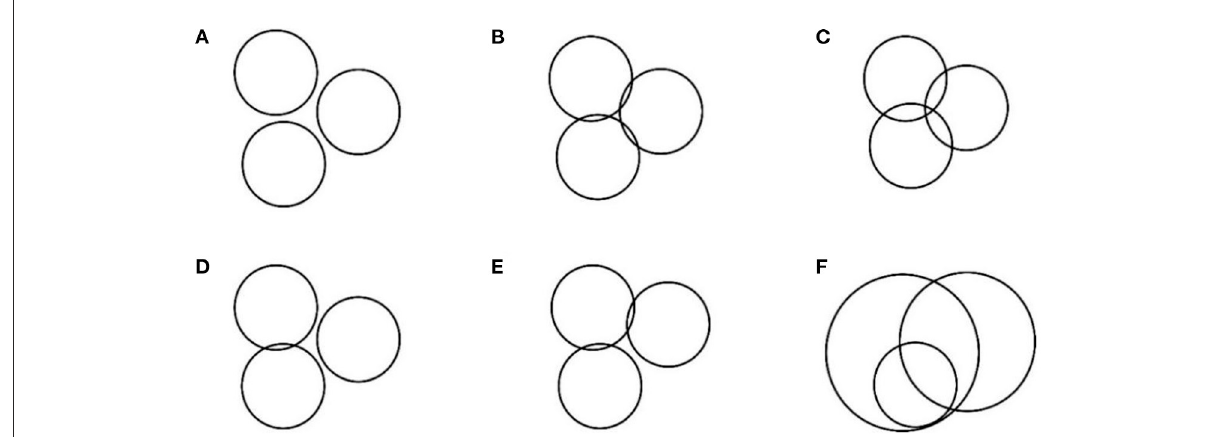
FIGURE2 (A–F) Possible error forms.